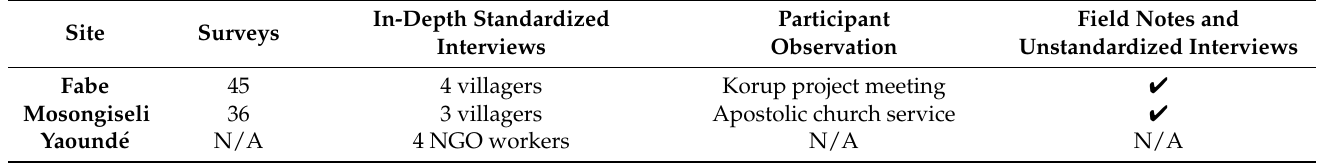
Table 2. Summary of primary data collected.